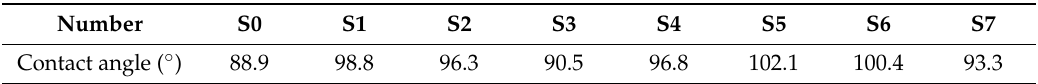
Figure 2. Optical images showing the contact angle measurements between deionized water and different surface ‐ modified 9Cr18 stainless steel specimens: ( a ) S0, ( b ) S1, ( c ) S2, ( d ) S3, ( e ) S4, ( f ) S5, ( g ) S6, and ( h ) S7. Table 2. The measured contact angles between different surface ‐ modified 9Cr18 stainless steel specimens and deionized water.